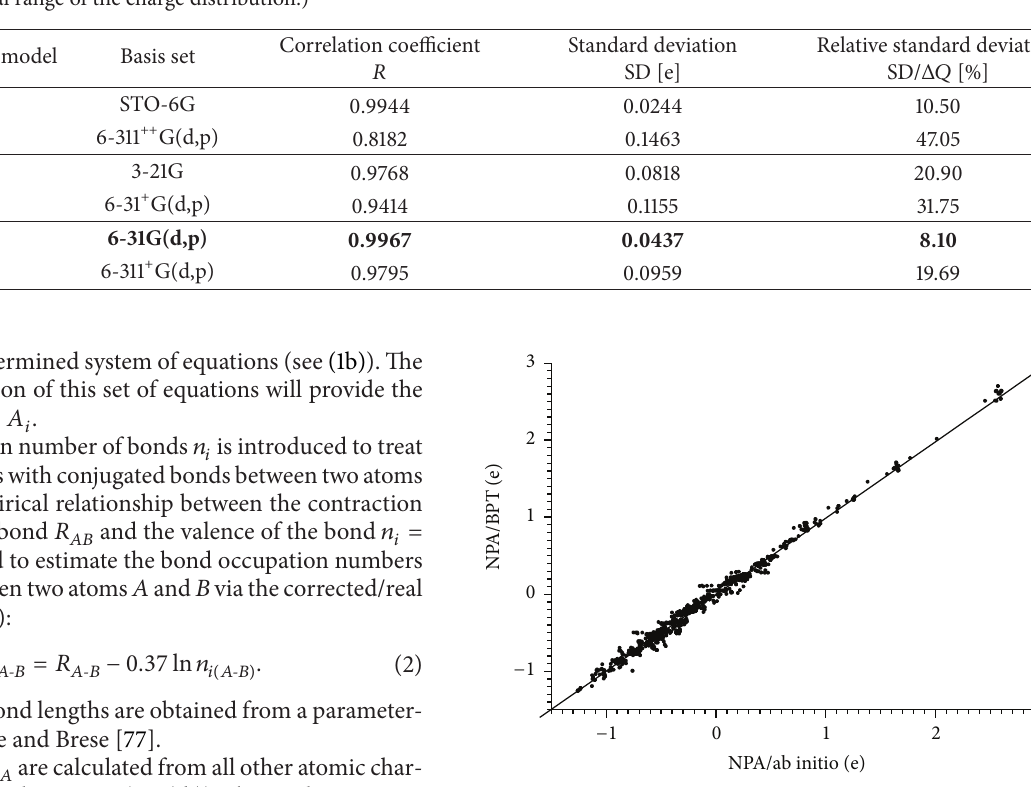
Table 1: Correlation coefficients ( 𝑅 ) and standard deviations (SD) of the parameterization of the BPT charge calculation based on selected different charge models MPA (Mulliken population analysis), ESP (charges derived from electrostatic potentials), and NPA (natural population analysis) of the best and worst performing basis sets for each model. The overall best performance, NPA/6-31G(d,p), is marked in bold. ( Δ𝑄 is the total range of the charge distribution.)